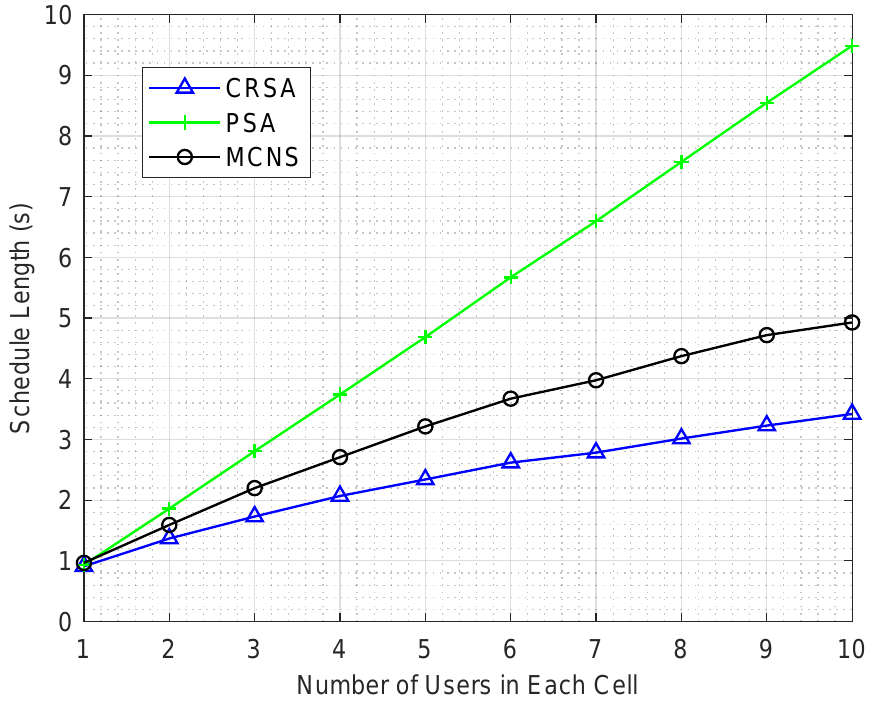
Figure 4. Schedule length of the algorithms for different number of users in each cell in a network of 10